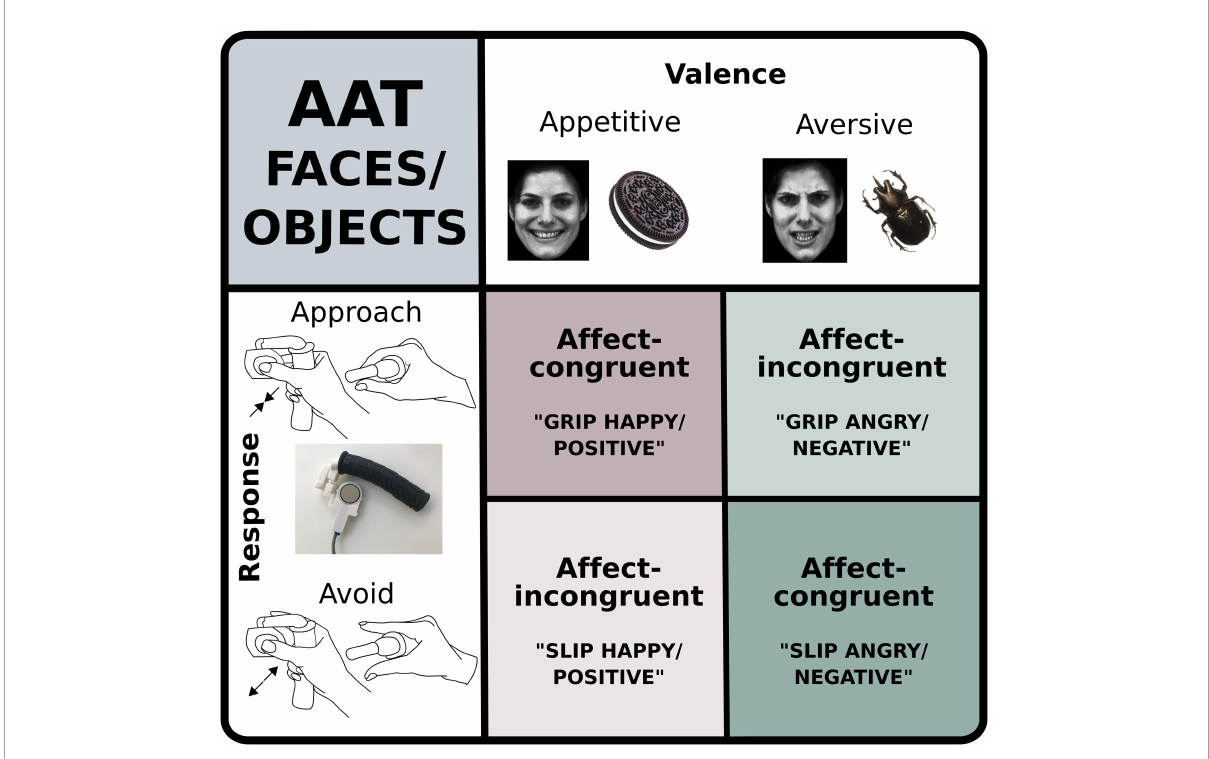
FIGURE1 Graphic representation of the two versions of the modified approach avoidance task (AAT). In one version, participants viewed happy and angry faces and in the other one they were viewing appetitive or aversive objects. At the sight of the images, they were instructed either to grip or slip a custom-made force device (see inset bottom left). In affect-congruent conditions participants were instructed to grip the device at the sight of happy faces or positive images and to slip the device at the sight of angry faces or negative images. In affect-incongruent conditions instructions were